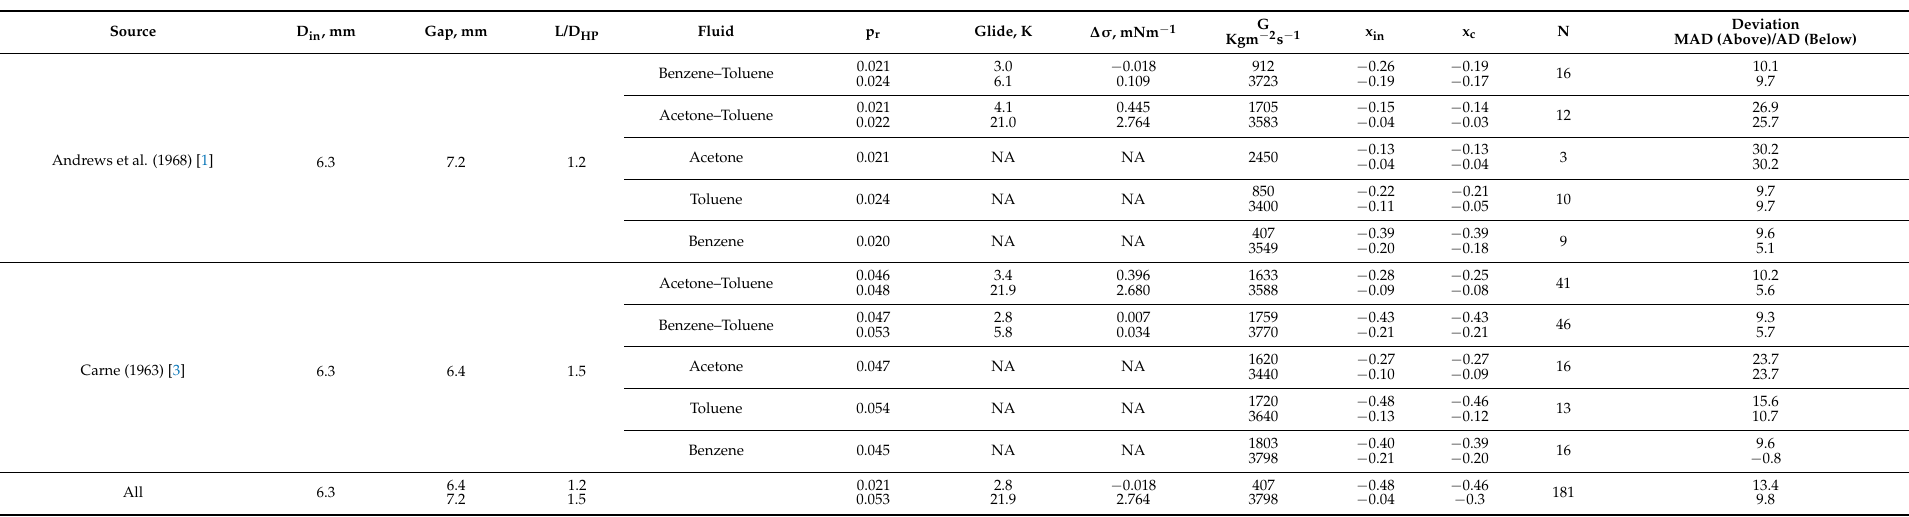
Table 2. Range of data for CHF in annuli and results of comparison with the Shah correlation. Mixture composition varied between 10 and 90% of each